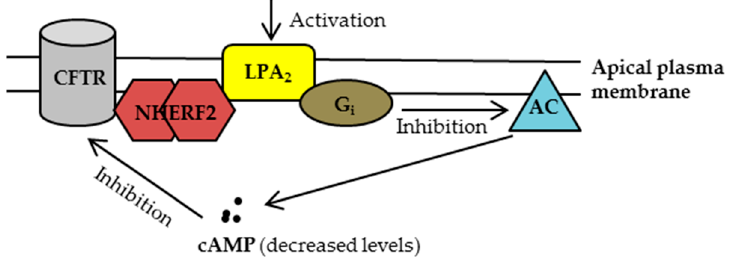
Figure 2. Once residing at the plasma membrane, the cystic fibrosis transmembrane conductance regulator (CFTR) forms a complex with Na + /H + exchanger regulatory factor 2 (NHERF2) and lysophosphatidic acid receptor 2 (LPA 2 ), which couples the LPA 2 -mediated signaling with CFTR channel activity in a compartmentalized manner. Upon activation of LPA 2 , adenylyl cyclase (AC) is inhibited through G i pathway, leading to a decreased cAMP level in proximity to CFTR and consequently inhibiting CFTR channel function. For clarity, only the major signaling molecules involved in this macromolecular complex are depicted here.